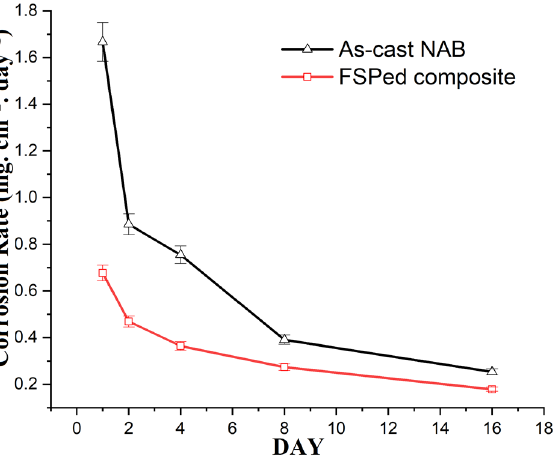
Figure 15. Corrosion rate of as-cast NAB and FSPed composite specimens after conducting static immersion tests in 3.5% NaCl solution.